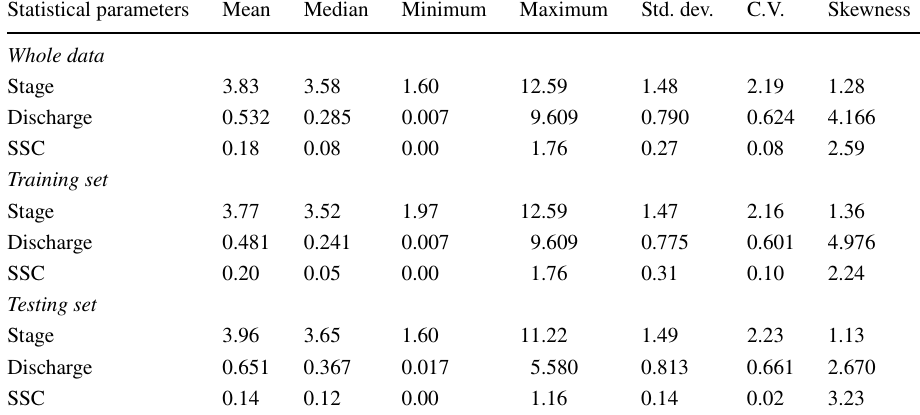
for all data, training data, and testing data of stage (m), discharge (m 3 /s), and SSC (g/l) for the Ghatshila site